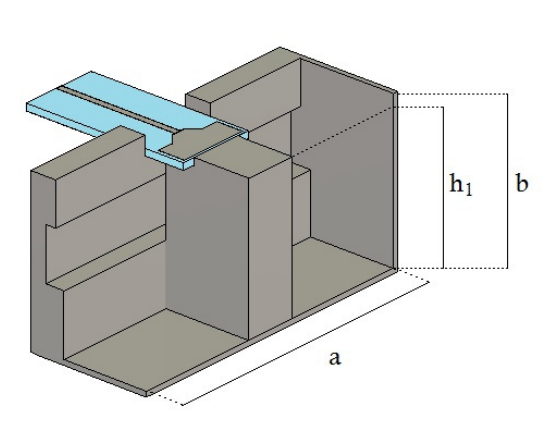
Figure 1. Geometry.